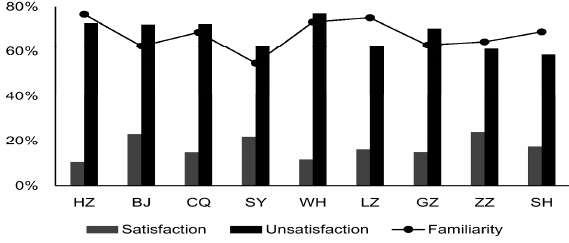
Figure 3. Resident’s response on familiarity and satisfaction with policy.